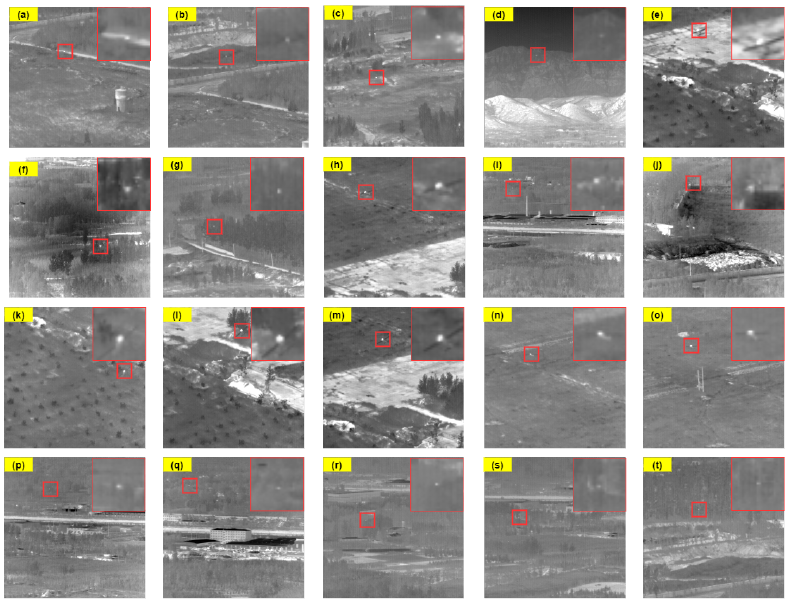
Figure 7. Partial presentation of the IDTAT dataset. The images ( a – t ) come from several different scenes and the number of pixels occupied by the target is very small. The small red box in the image is the area where the target is located, and it will be enlarged and displayed in the big red box in the upper right